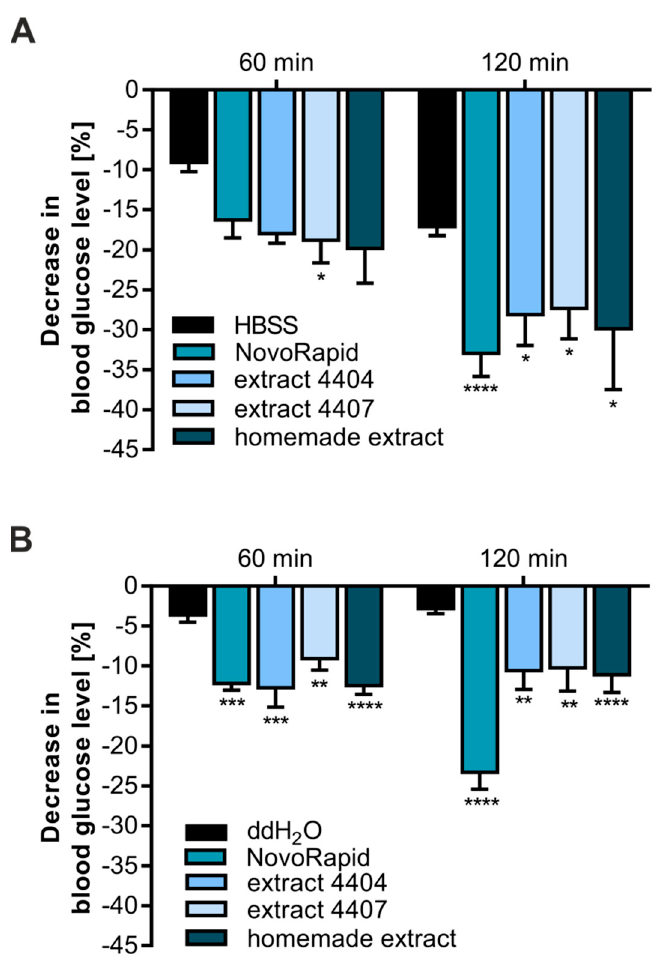
Figure 2. Influence of extracts prepared from bellis perennis on blood glucose levels in ovo. Eggs were incubated for 11 days and treated with the indicated substances (NovoRapid: 3.3 U/mL; extracts: 300 mg/L) dissolved in HBSS buffer ( A ) or ddH 2 O ( B ) (300 µ L volume) for up to 2 h. Blood glucose levels were determined with a blood glucose meter. Error bars are based on the standard error of the mean. * p < 0.05, ** p < 0.01, *** p < 0.001 and **** p < 0.0001, with a significant decrease with respect to HBSS or ddH 2 O treated eggs of the same incubation time.